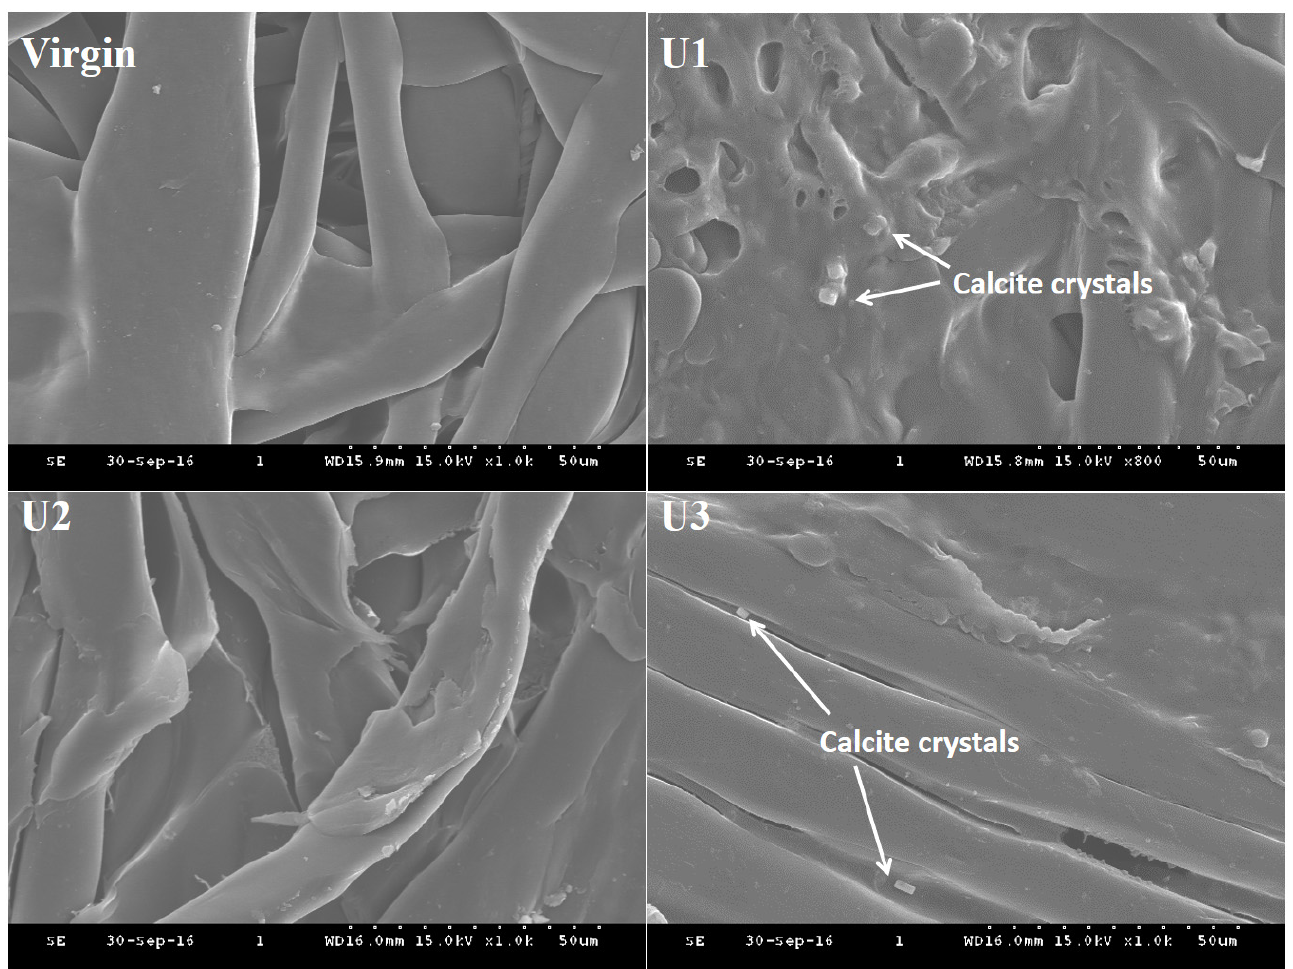
Figure 5. The higher-magnified SEM images of membrane surfaces.